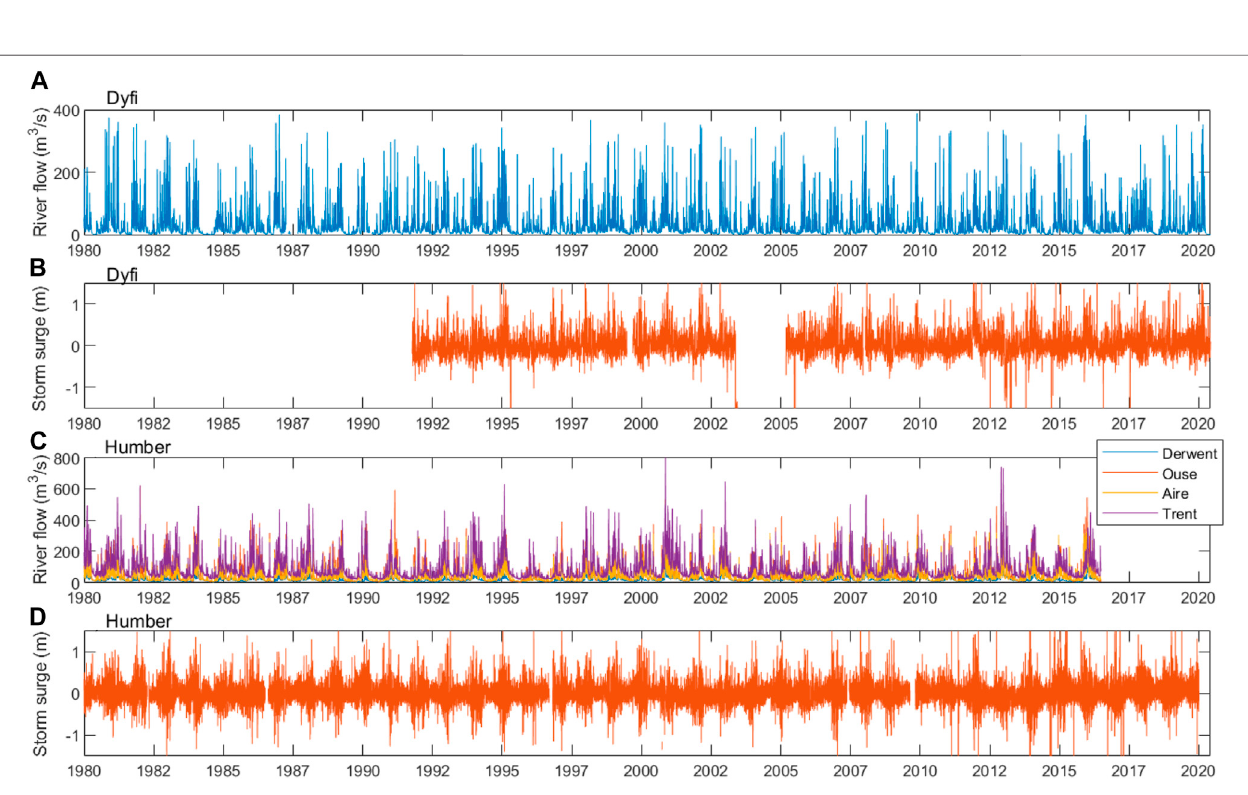
Frontiers in Built Environment |